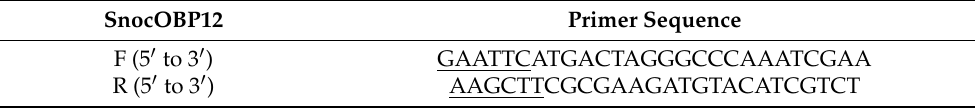
Table 1. Primers used for cloning of